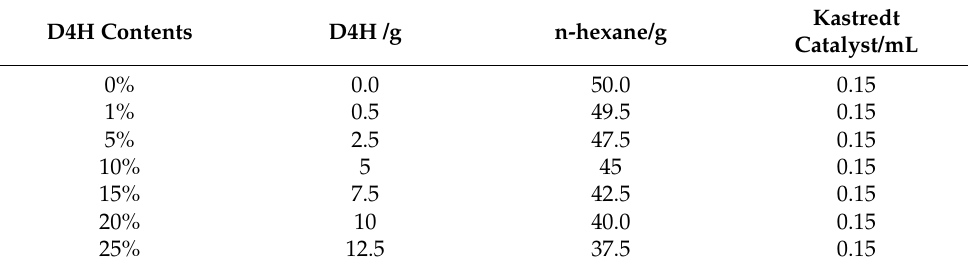
Table 1. Formula for D4H modifier